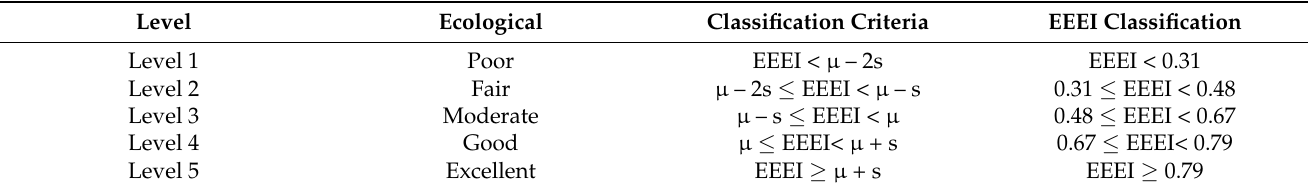
Table 5. Classification criteria of ecological quality of the GBA from 2000 to 2020.